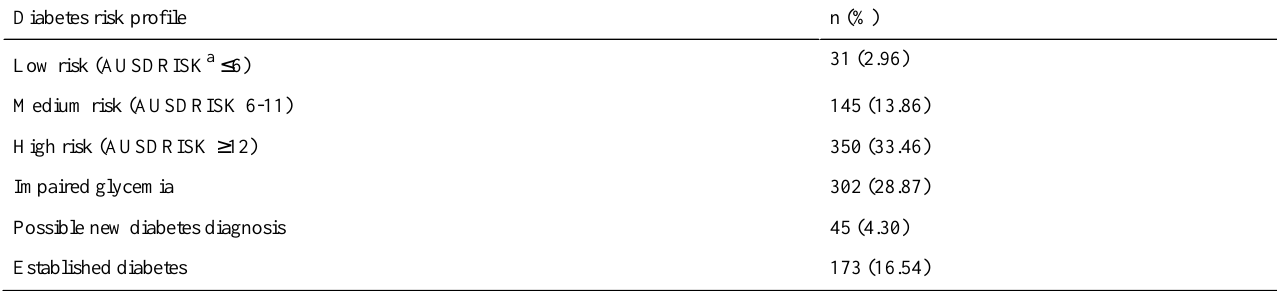
Table 5. Diabetes risk profile for 1046 people.